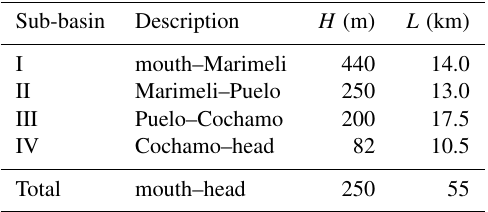
Table 1. Characteristics of the Reloncaví fjord. The name, mean depth ( H ), and length ( L ) of each sub-basin and for the entire fjord are